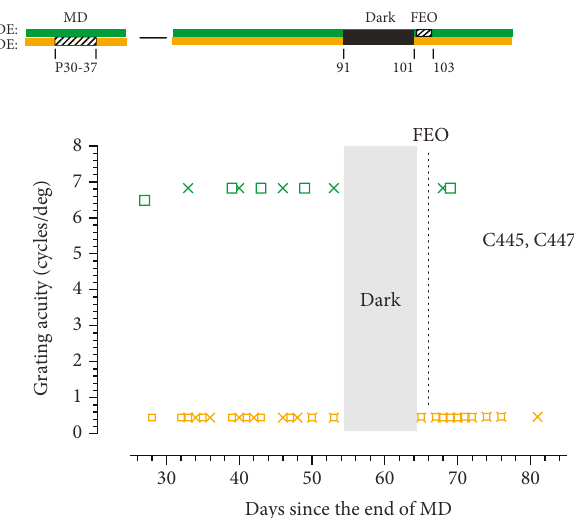
Figure 6: The grating acuity of the deprived eye acuity (orange symbols) and the binocular acuity (green symbols) of two monocularly deprived littermates C445 (square symbols) and C447 (cross symbols) surrounding 10 days of total darkness followed immediately by a 2-day period of fellow eye occlusion (FEO). Whereas the period of FEO e ff ectively blocked any improvement of the acuity of the deprived eye following the period of darkness, it did not result in any reduction of the acuity of the nondeprived